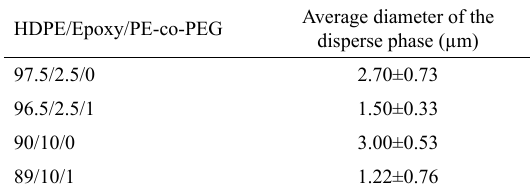
Average diameter of the disperse phase (µm)